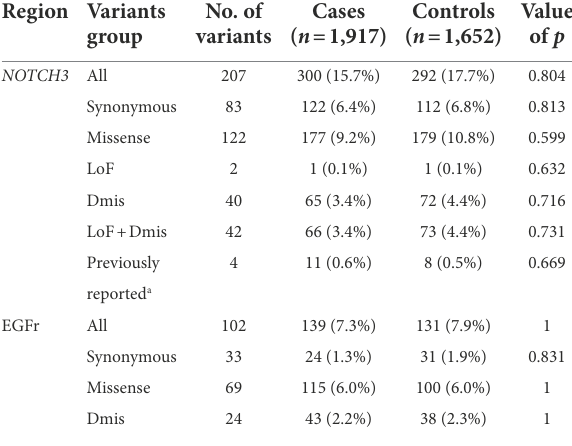
receptor family. In 1993, the data obtained from two French